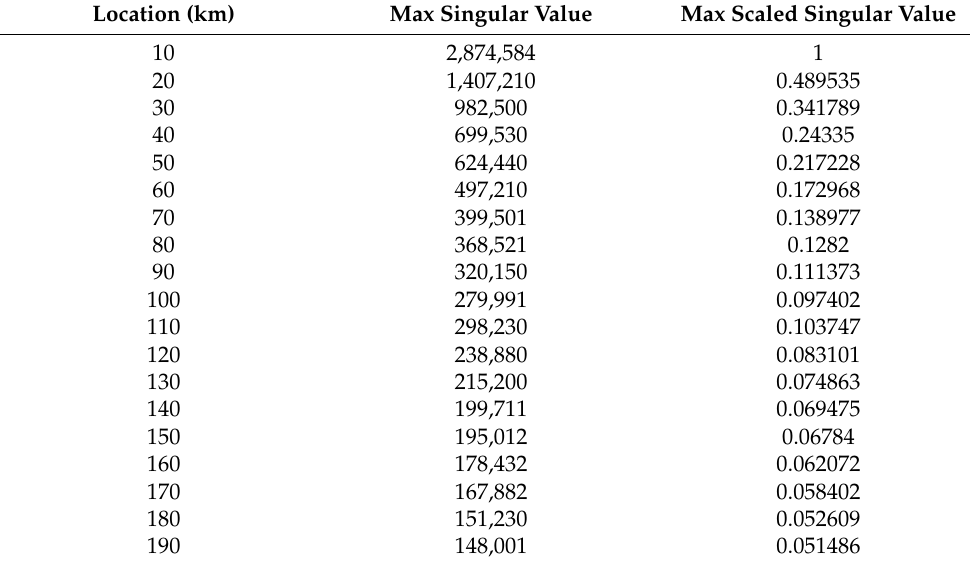
Table A10. The maximum singular and its scaled values for LL-G fault at 19 locations.